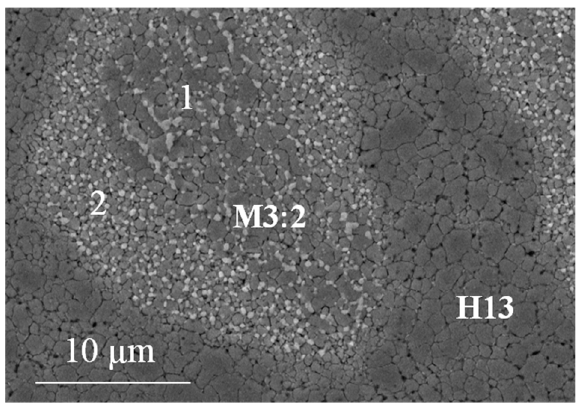
Figure 10. Microstructure of the hybrid tool steel showing the H13 and M3:2 regions. Please note the different grain sizes and carbide distributions in the outer (2) and inner (1) M3:2 particle regions due to the different extent of plastic deformation after milling (see also Figure 3d).